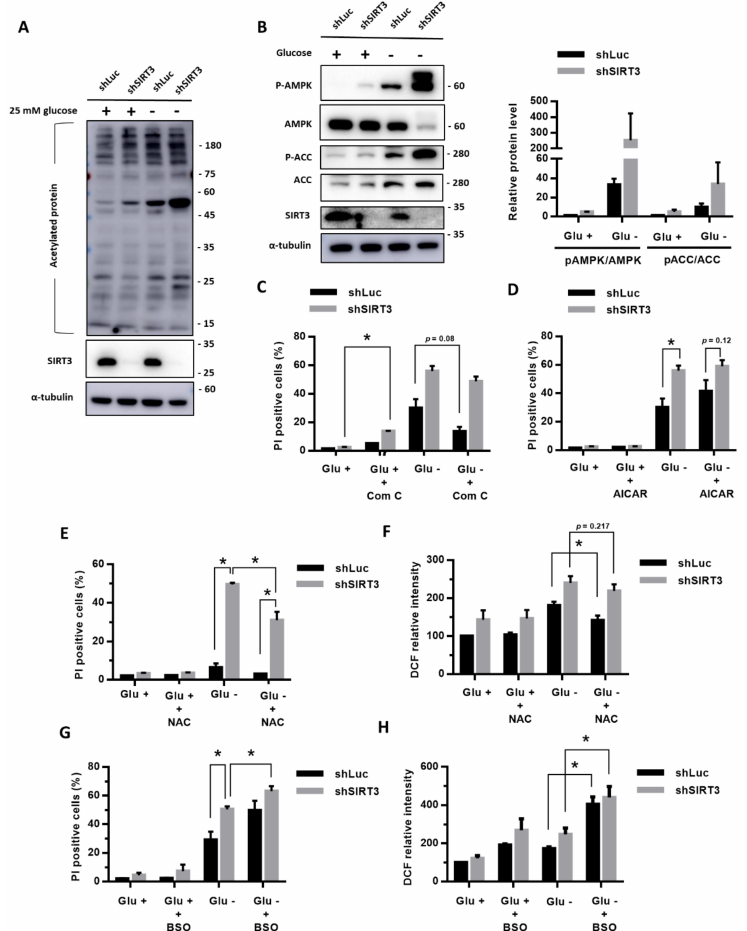
Figure 3. Knockdown of SIRT3 enhanced the ROS levels and promoted cell death in the cells under glucose deprivation. ( A – D ) The MDA-MB-231 cells with shSIRT3 to knockdown SIRT3 or control shLuc were treated with or without glucose deprivation for 24 h. ( A ) The level of acetylated protein was detected using a Western blot. ( B ) The protein levels of AMPK pathway were detected using a Western blot. ( C , D ) The cell death rate after cotreatment with Com C (10 µ M) ( C ) or AICAR (1 mM) ( D ) for 24 h was detected using flow cytometry with a PI exclusion assay. ( E – H ) The antioxidant N-acetyl-cysteine (NAC) or the glutathione biosynthesis inhibitor L-buthionine-S, R-sulfoximine (BSO) was cotreated for 24 h. The cell death rate was evaluated using flow cytometry with a PI exclusion assay ( E , G ). The intracellular ROS levels were detected using flow cytometry with DCFH-dA staining ( F , H ). The measured value of the DCF intensity from the cells with shLuc in glucose-containing medium was normalized as 100%. The data are presented as the mean ± SEM of the results from three independent experiments in triplicate. n = 3. * ( C – H ): p < 0.05. Glu + : medium containing 25 mM glucose. Glu -: glucose-free